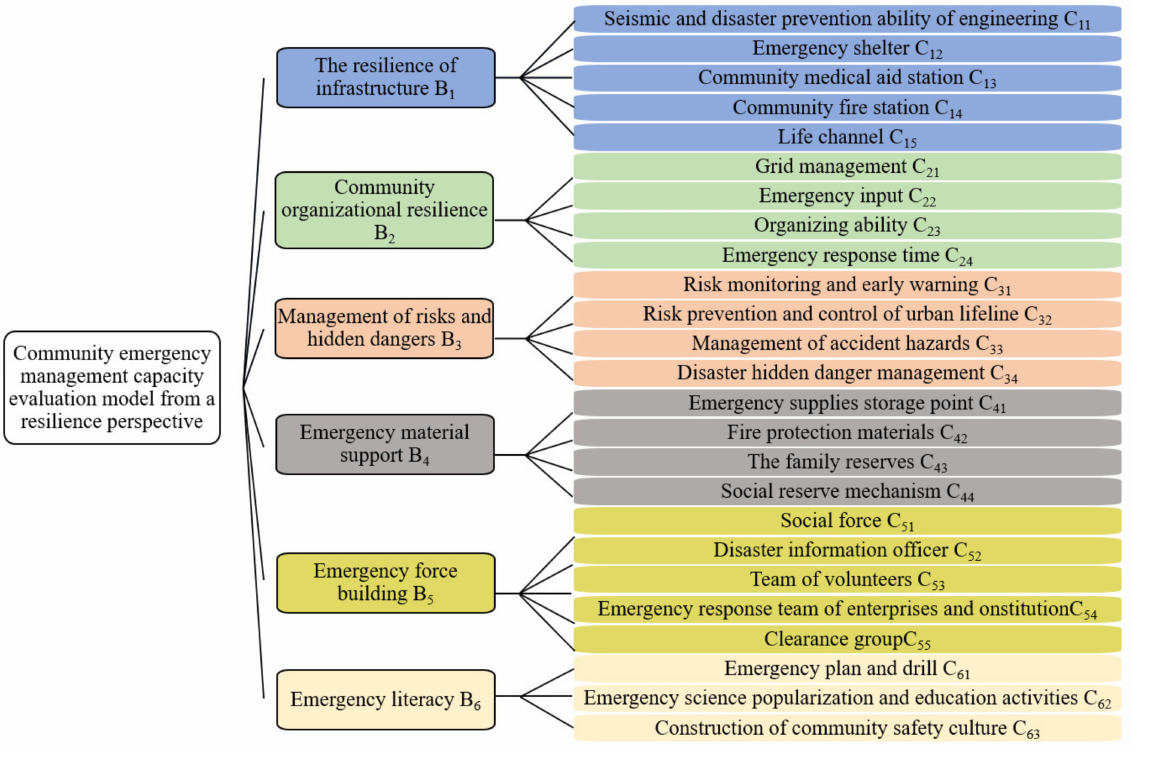
Figure 3. Community emergency management capacity evaluation indicators from a resilience